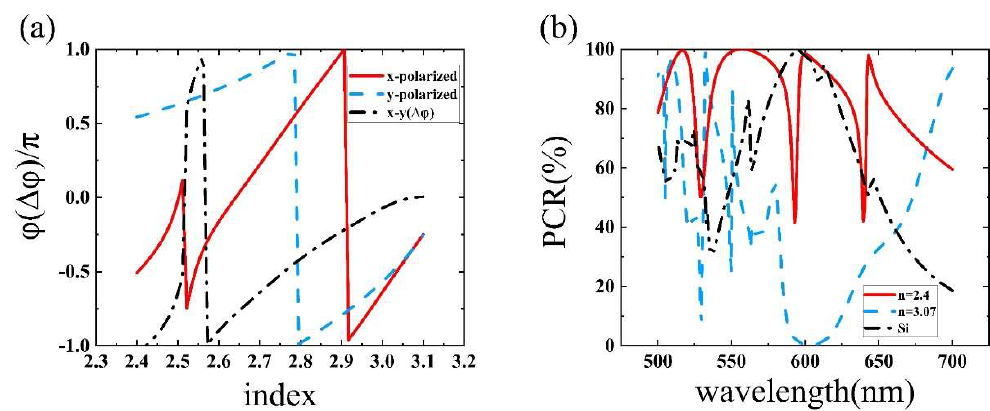
Figure 4. ( a ) Phase shift of the linearly polarized beam along ordinary axes (x-polarized) and extraordinary axes (y-polarized) and phase shift difference between them when the refractive index of the BTO nanofin changes from 2.4 to 3.1. ( b ) PCR of the BTO nanofin ( n = 2.4 and n = 3.07) and the Si nanofin.